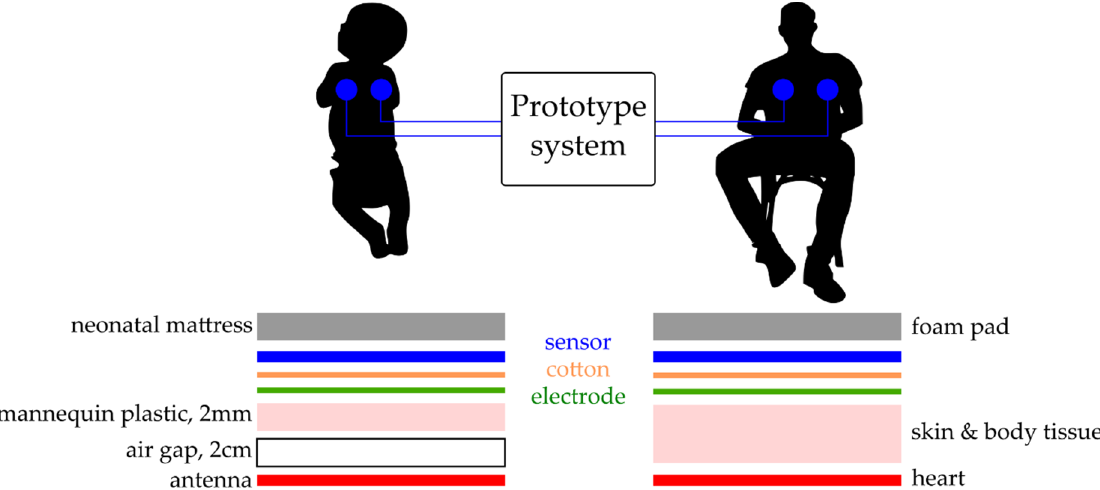
Figure 9. Experimental set up—electrode placement and interference layers for simulated and human ECG readings, left neonate mannequin, right human volunteer.